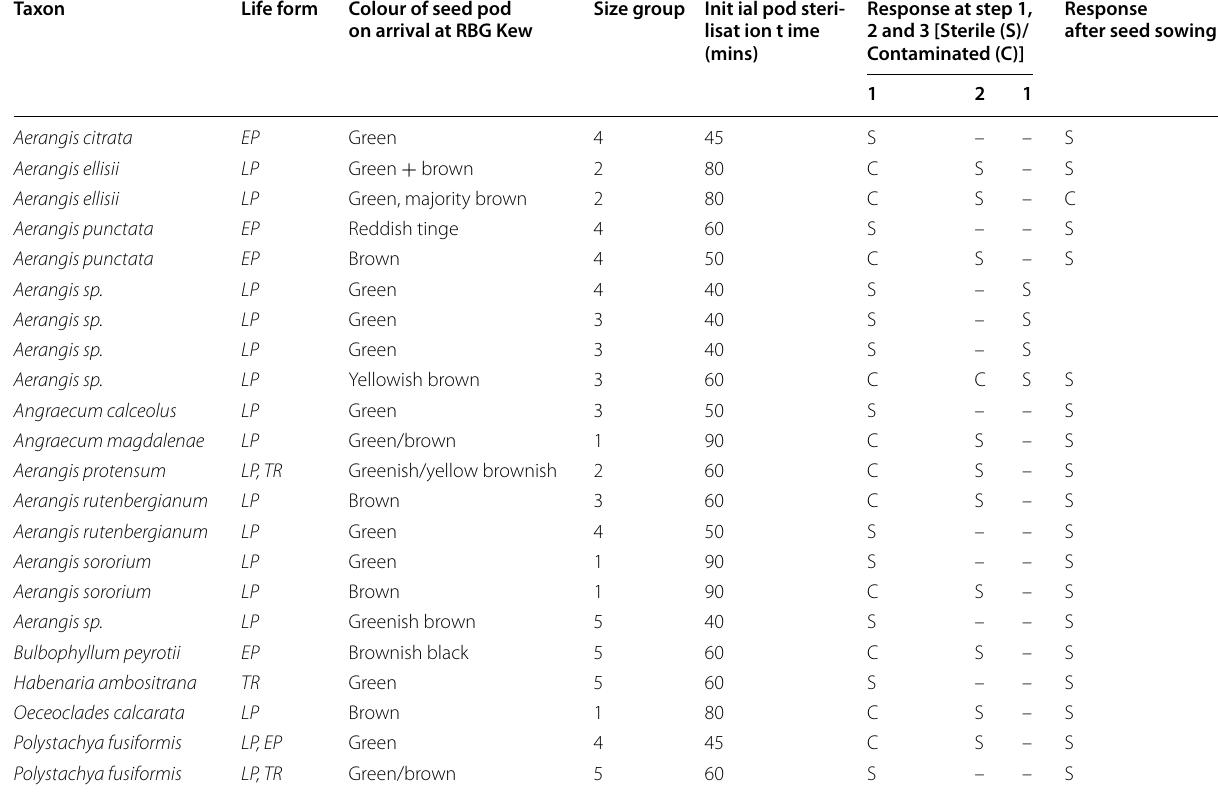
Table 1 List of taxa from Itremo, Central Highlands, Madagascar: seed capsule size and seed capsule colour 2–3 weeks after in vitro collecting and results of seed capsule sterilisation that yielded clean seeds 3 weeks after